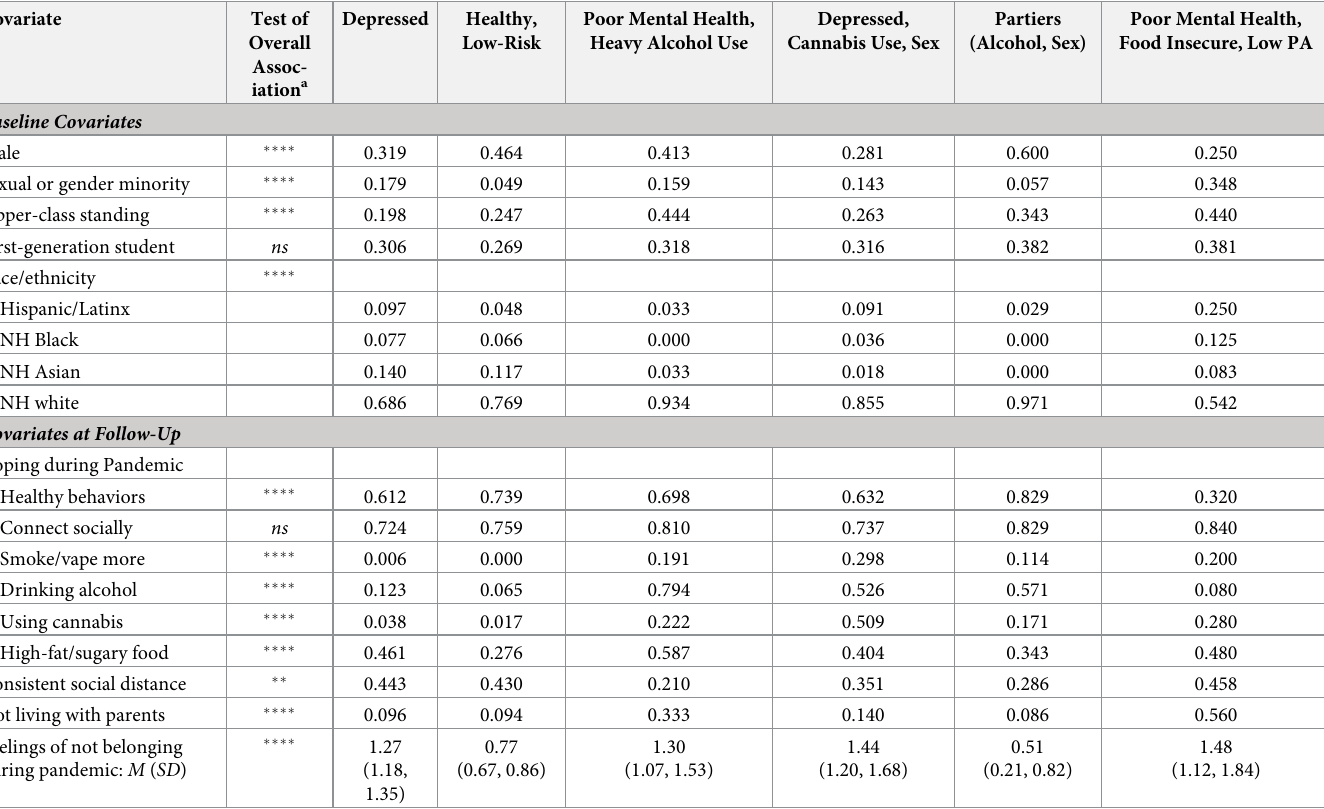
Table 7. Covariates of health and well-being latent class membership during the pandemic: Class-specific proportion (mean) of individuals with each characteristic at follow-up.